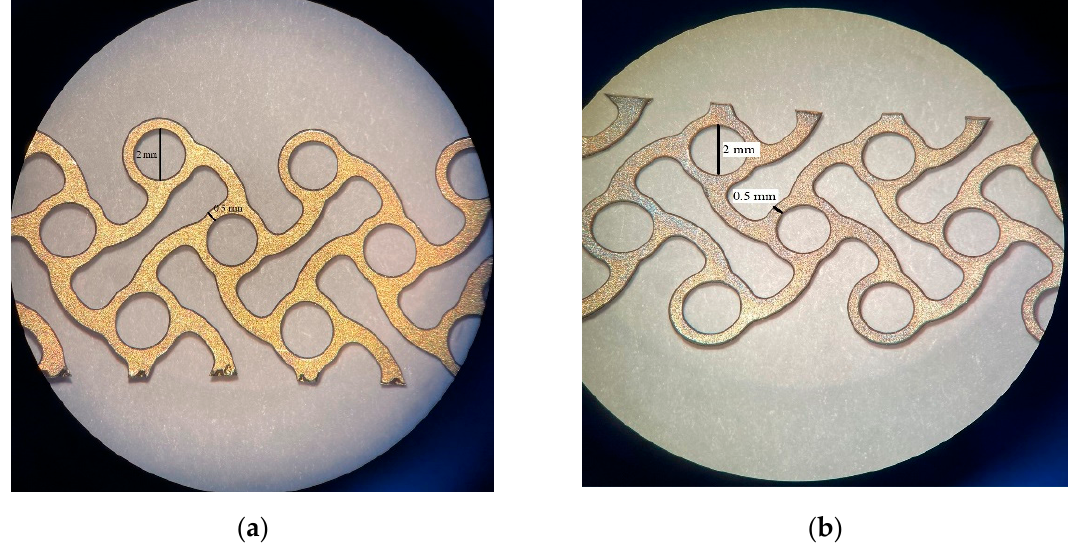
Figure 1. Titanium mesh surfaces—coated with hydroxyapatite for orbital wall reconstruction: ( a ) Microscopic image of the top face; ( b ) Microscopic image of the bottom face.